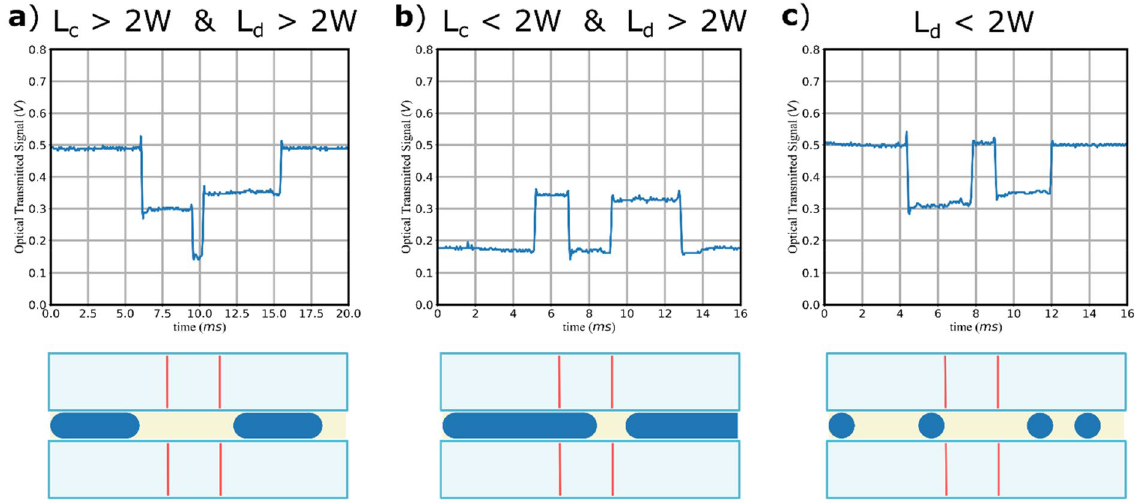
Figure 4. Detection regimes of droplets. Three possible regimes in terms of OT can occur when a droplet flows in front of the Mach Zehnder Interferometer, depending on the value of 2 W with respect to the length of the object L c and the distance between two consecutive objects L d . ( a ) Both L c and L d are higher than 2 W, and therefore the droplet can interact with one or both the waveguided arms; ( b ) when L c is smaller than 2 W but L d is longer than 2 W, respectively always one or both the MZI branches are interacting with the droplet; ( c ) when both L c and L d are smaller than 2 W , the two branches cannot interact simultaneously with the same droplet. The measurements of the length and velocity can be made in all regimes just by triggering the timing of transition between the interaction